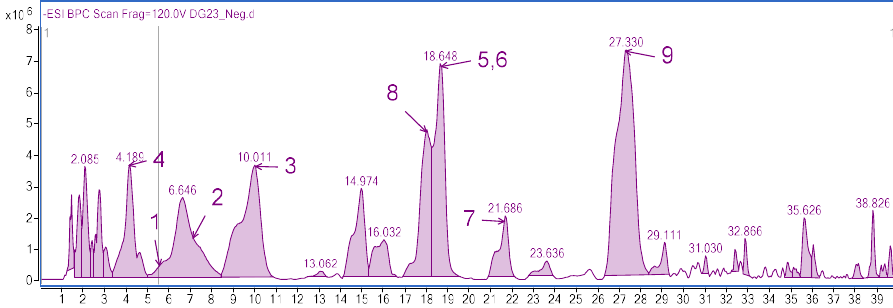
Figure 1. HPLC spectra of methanolic extract of R. graeca . 1 : Chlorogenic acid, 2 : ca ff eic acid, 3 : rutin, 4 : quercetin 3-rutinoside-7-rhamnoside, 5 : rabdosiin disodium salt, 6 : rabdosiin, 7 : salvianolic acid a, 8 : rosmarinic acid, and 9 : salvianolic acid B. Table 1. LC/MS analysis of methanol extract of R. graeca .